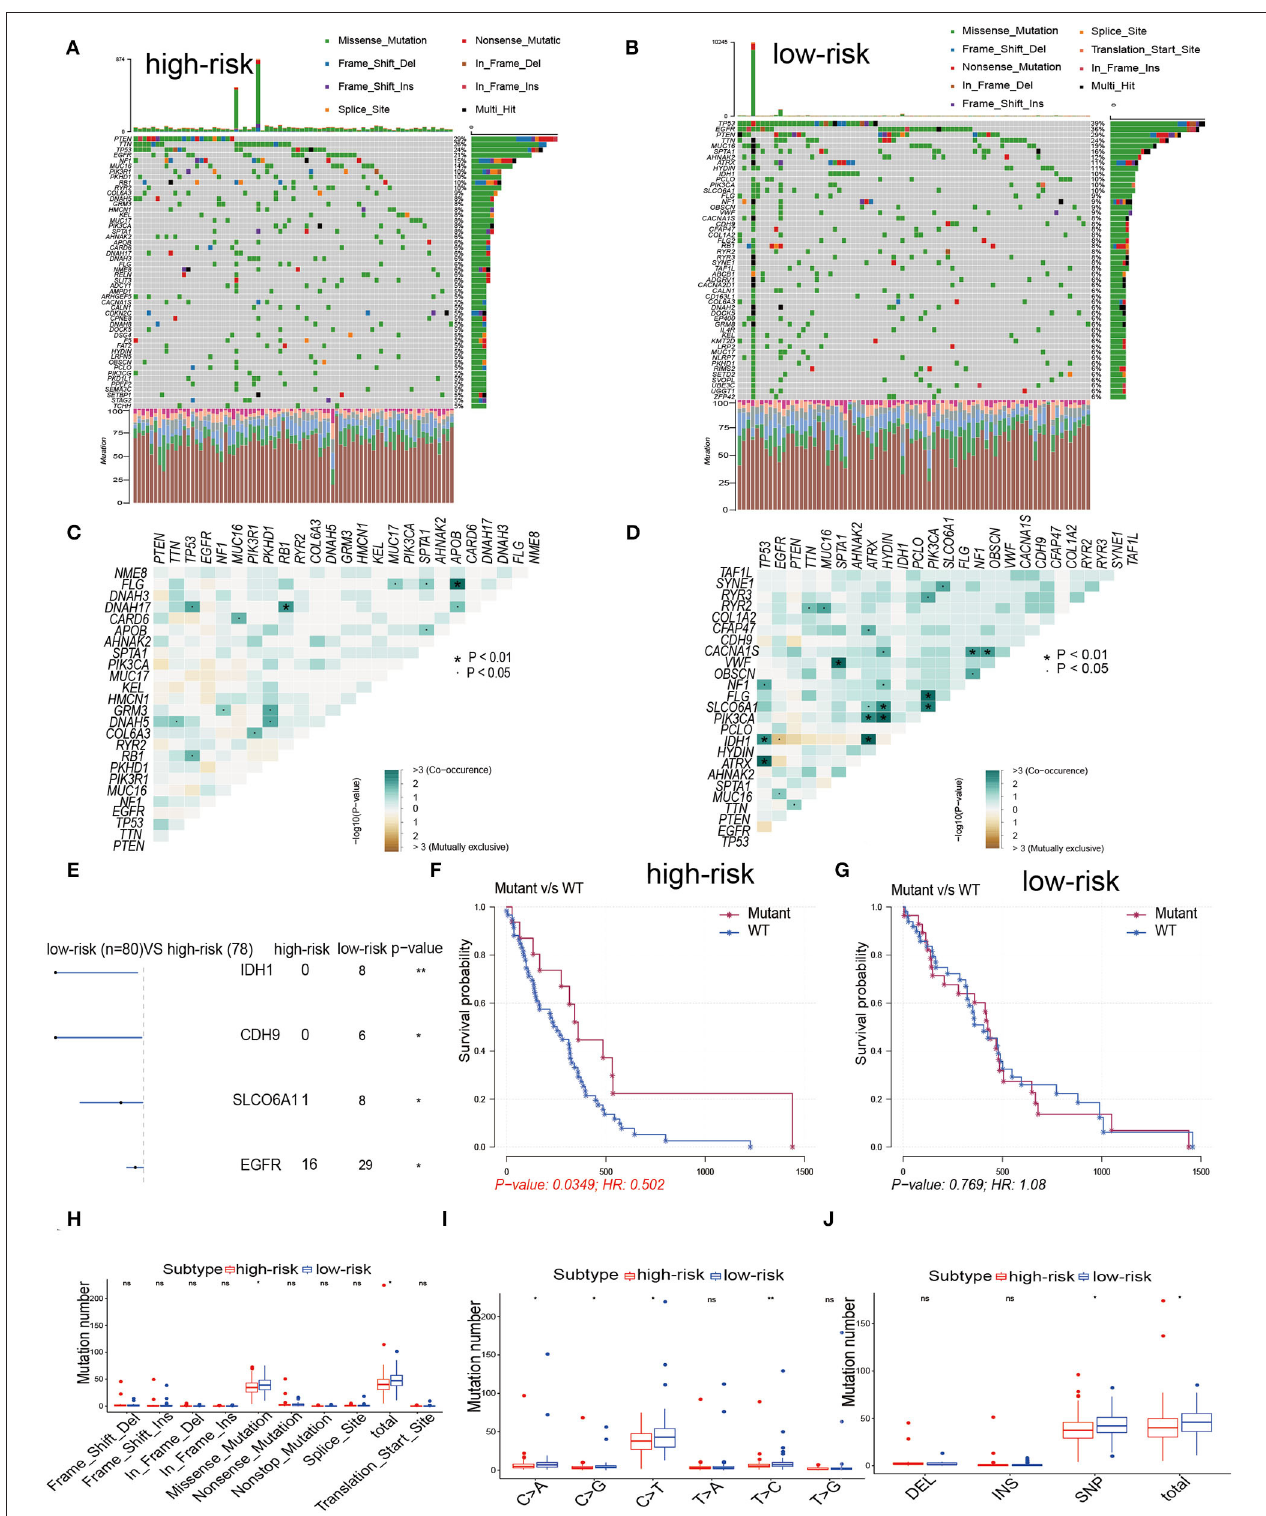
FIGURE 6 | The landscape of somatic Mutations in high and low-risk groups. (A , B) The distribution of mutations based on the top 50 most commonly mutated genes is displayed in the waterfall plot. Each GBM sample mutation type is shown in the central panel, and the TMB for each GBM sample is shown in the upper panel. The mutated genes and mutation rate of genes mutated in both cohorts are shown. The lower section shows the SNV type for each sample. The top panel showed the